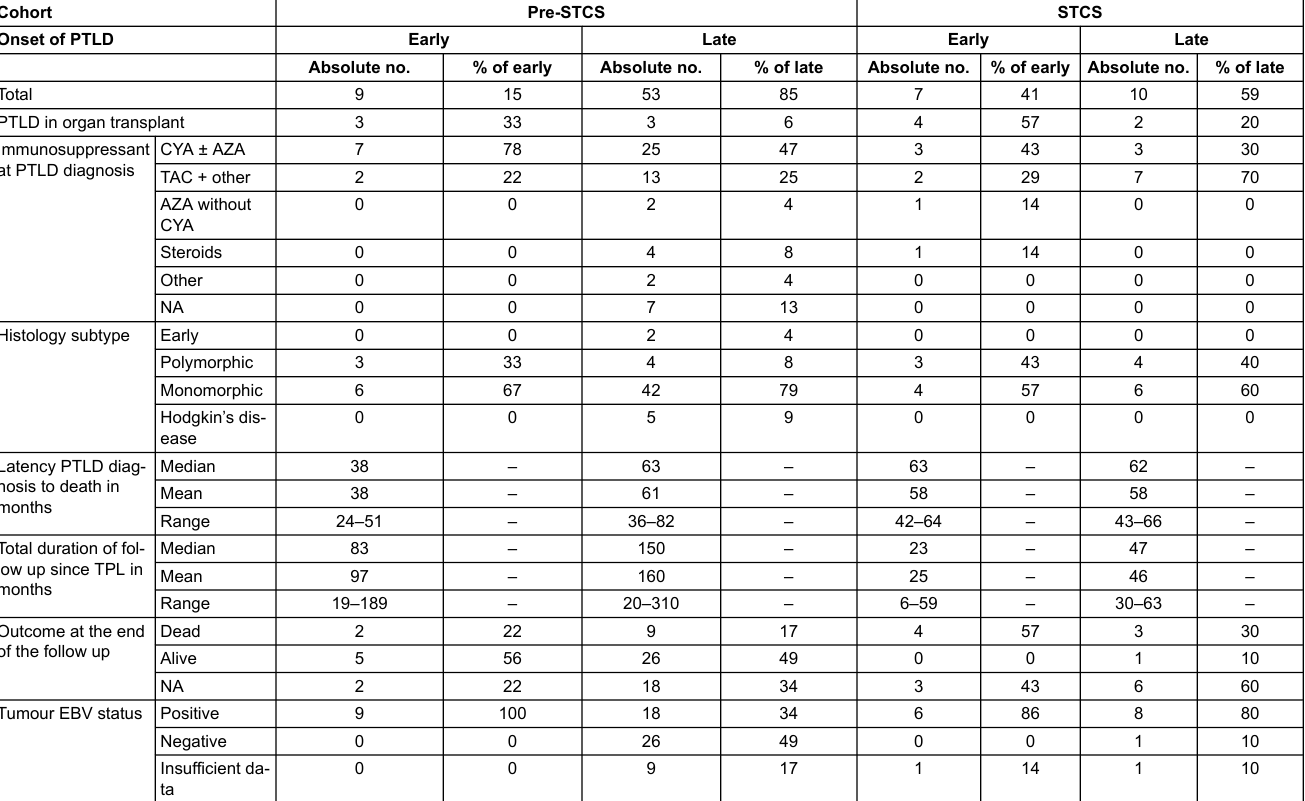
Table 3: Early versus late onset post-transplant lymphoproliferative disorder (PTLD).